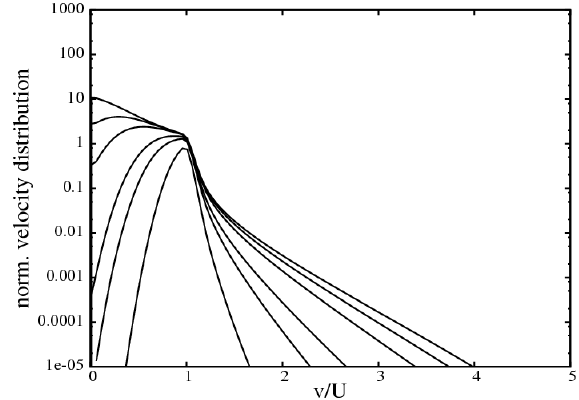
Fig. 3. The (normalized) approximated self-consistent velocity dif- fusion coefficient given by Eq. (3).